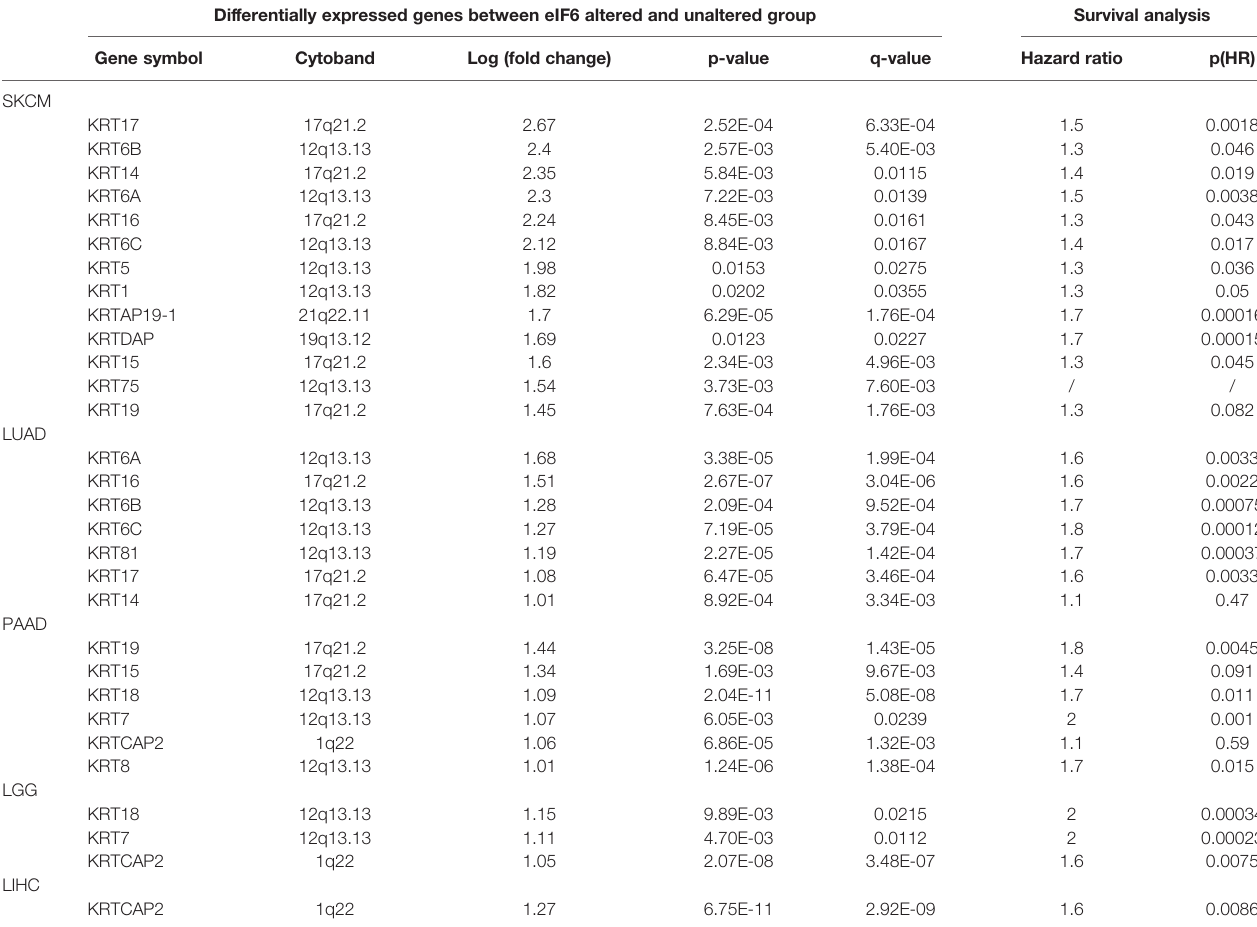
TABLE 1 | Up-regulated keratin genes of the high-eIF6 expression group in SKCM, LUAD, PAAD, LGG, and LIHC. Differentially expressed genes between eIF6 altered and unaltered group Survival analysis Gene